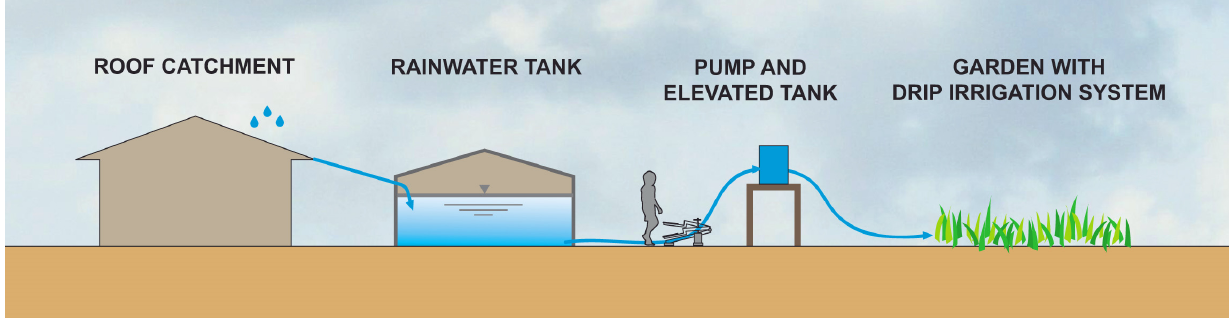
Figure 1. Rainwater harvesting and gardening facility with roof catchment and storage tank